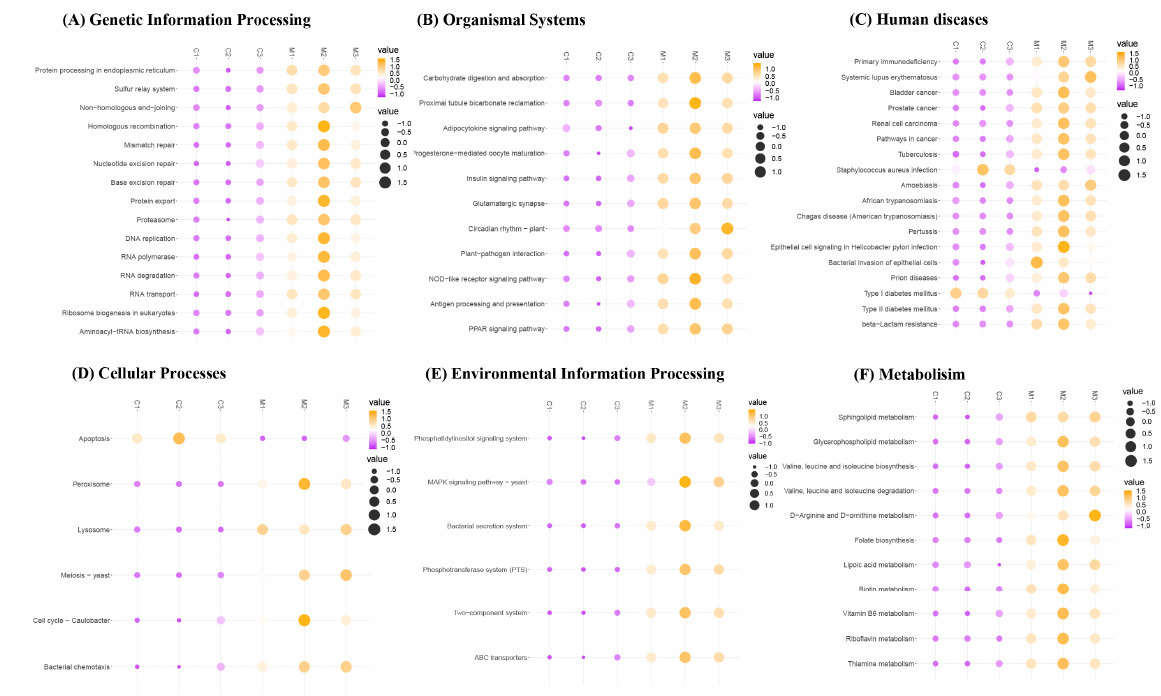
Figure 6. The predicted functional differences based on the KEGG (Kyoto Encyclopedia of Genes and Genomes) of the metabolic pathways of the gut microbiota at 18 weeks: ( A ) Genetic Information Processing; ( B ) Organismal Systems; ( C ) Human Diseases; ( D ) Cellular Processes; ( E ) Environmental Information Processing; and ( F ) Metabolism. C1, C2, and C3 belong to the Control group, whereas M1, M2, and M3 belong to the MFGM group. Control: fed with saline; MFGM: fed with 400 mg/kg BW milk fat globule membrane.